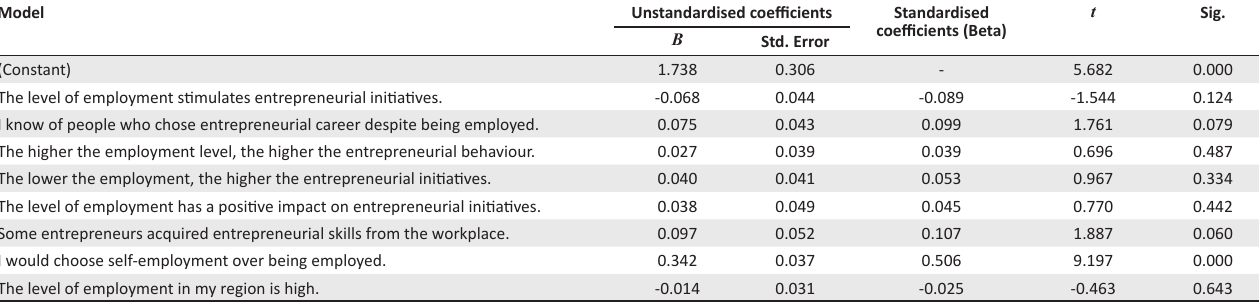
TABLE 8: Regression between employment level and entrepreneurial intentions. Model